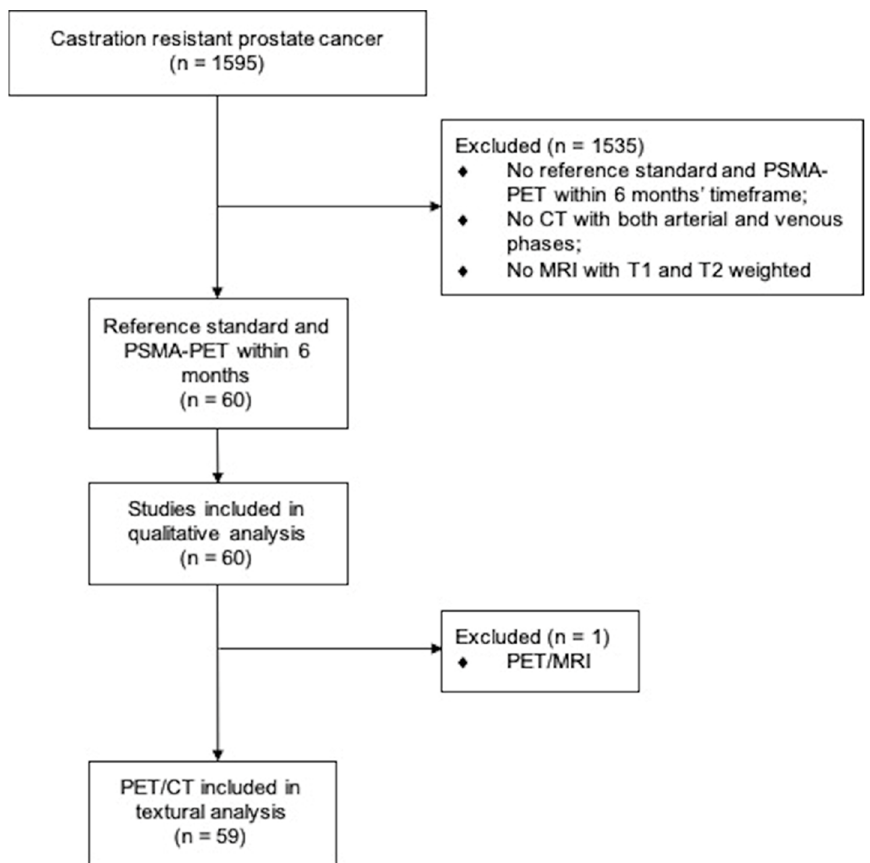
Figure 1. Consort diagram flow for patient selection.